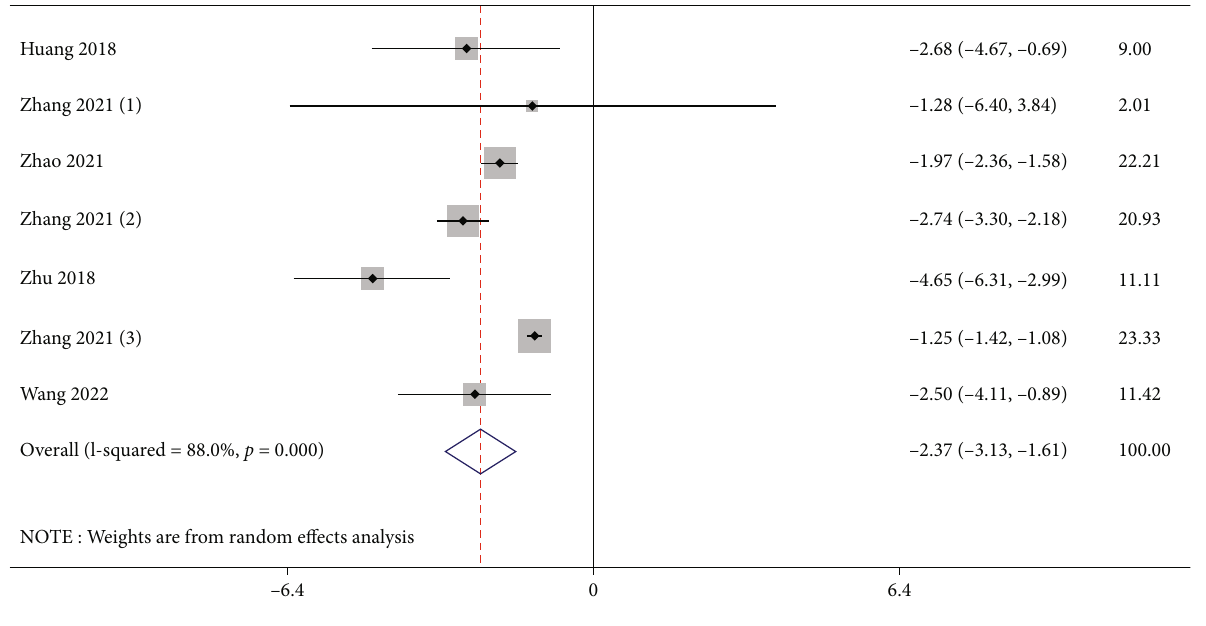
Figure 6: Forest illustration of the serum urea nitrogen.